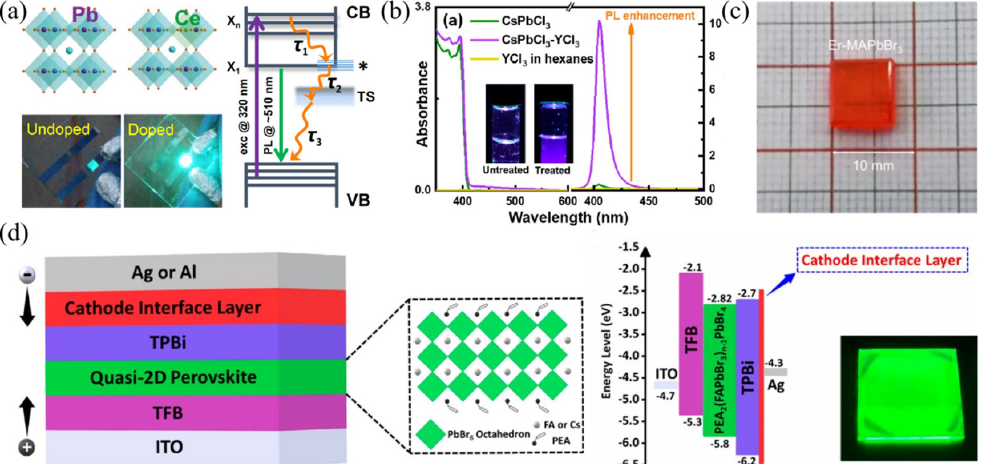
Figure 8. ( a ) Crystal lattice structure of Ce 3+ -doped CsPbBr 3 , LED photographs, and schematic dia- gram of photophysical mechanism (Reprinted/adapted with permission from Ref. [63]. Copyright